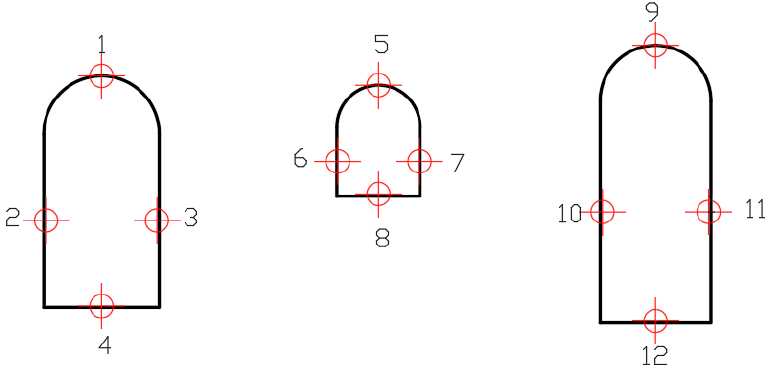
Figure 13. Setting of key points of cavern group.( Note: The numbers in the picture represent the key point number).